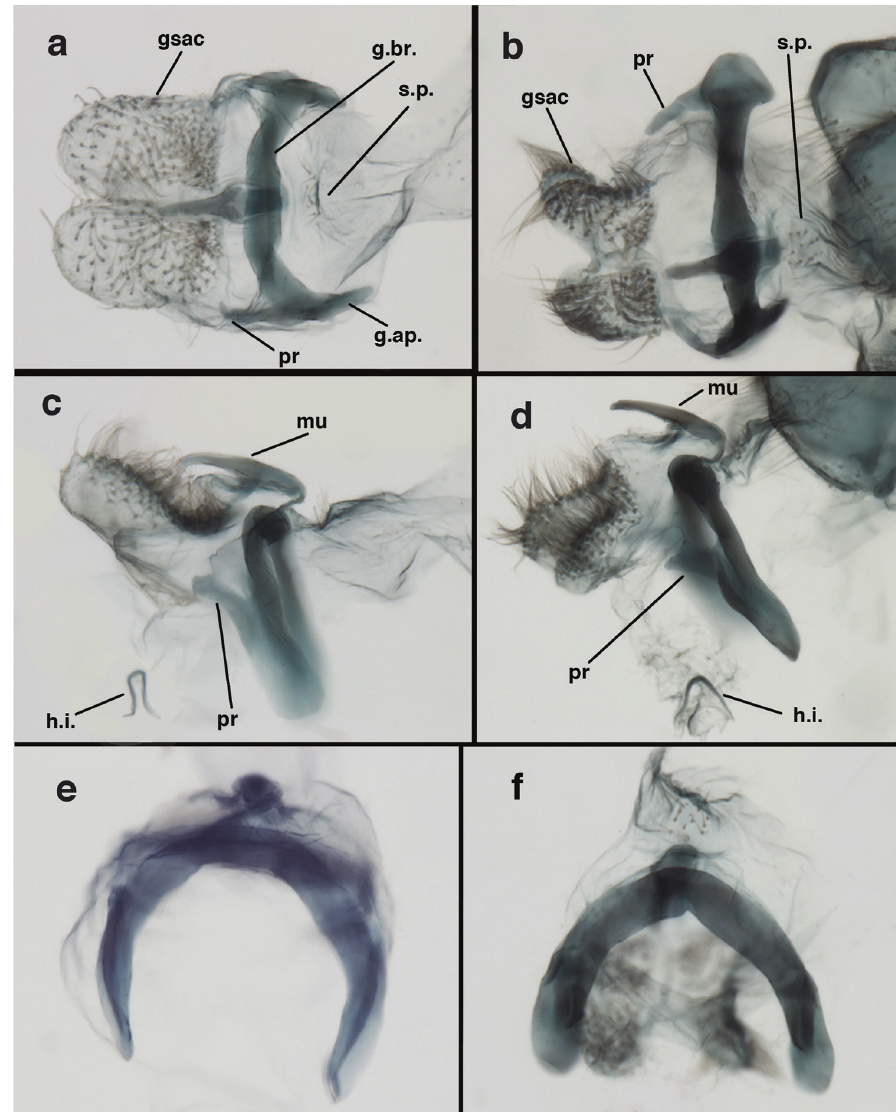
Figure 133. Ungla elbergi Tauber, sp. n. Male genitalia, ( a, b ) gonarcal complex, dorsal ( c, d ) gonar- cus, lateral (slightly different angles) ( e ) gonarcus, posterior ( f ) gonarcus, posterodorsal. gsac gonosac- cus g.ap. gonarcal apodeme g.br. gonarcal bridge h.i. hypandrium internum (probably broken in “c”) mu mediuncus pr unarticulated process on frontal margin of gonarcal apodeme s.p. setose subanal plate (Argentina; a, c, e Tucumán, holotype, EMEC; b, d, f Jujuy, paratype, FSCA). E Gonzáles Olazo, G Sziráki (M, IFML). La Rioja: Santa Cruz, 1600 m, 1/XII/2002, L. A. Stange (1F, EMEC). Tucumán: Tafi Viejo, Alpo Puyo, 15/VIII/1998, Col. C. Reguilón (1M, FSCA), 23/V/1998, Col. Núñez G. (1F,